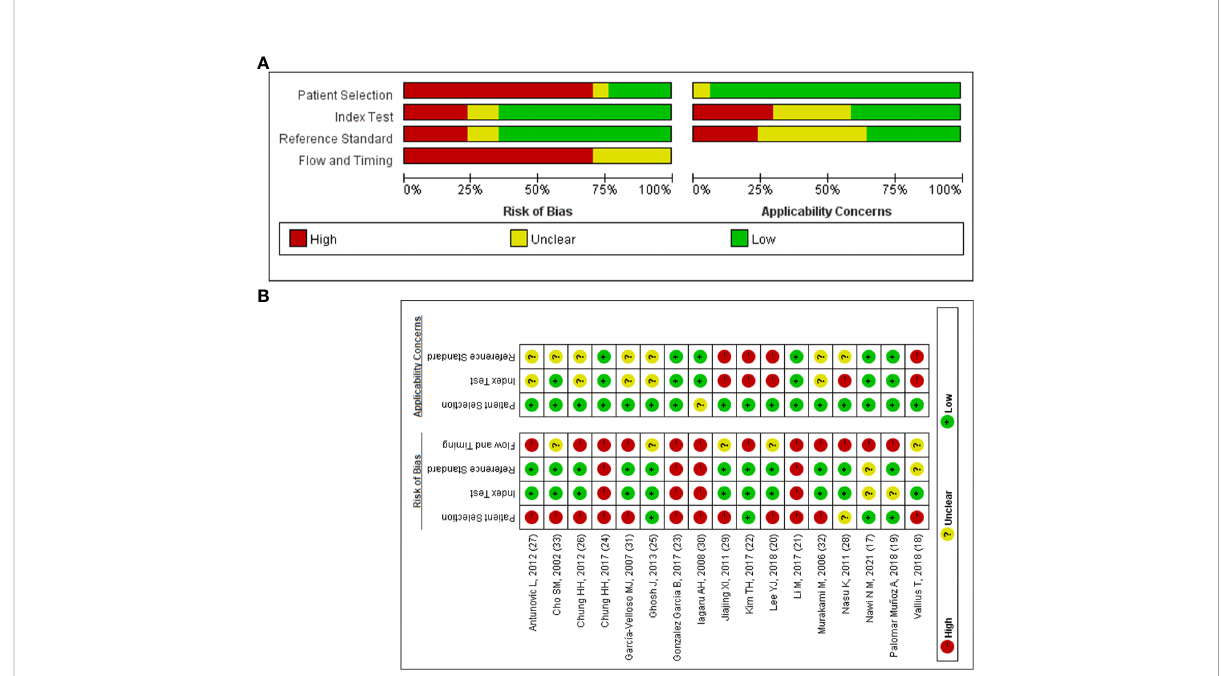
FIGURE 2 The quality of included articles according to the QUADAS-2 guidelines. (A) Risk of bias summary; (B) Risk of bias graph.